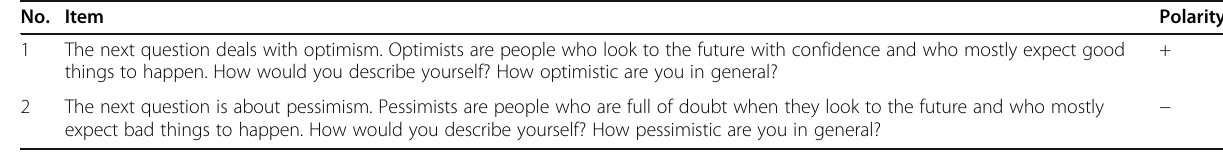
Table 1 Wording of English-language SOP2 items No.